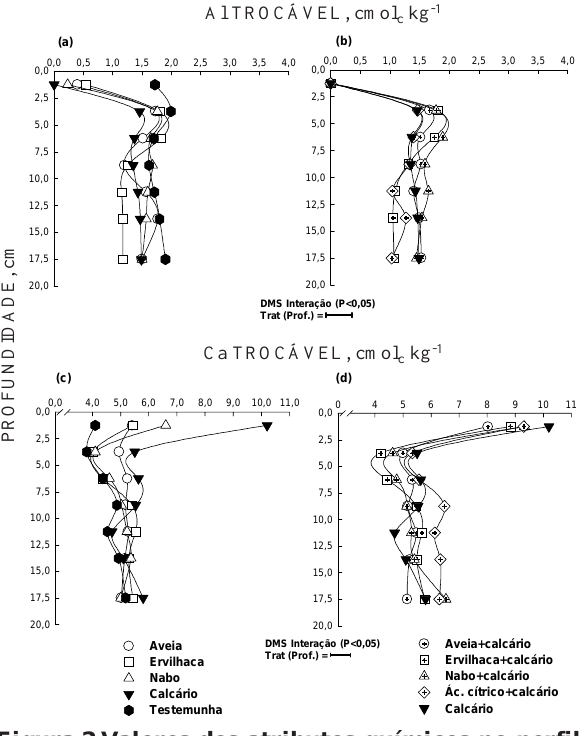
Figura 2 Valores dos atributos químicos no perfil do solo após 60 dias da aplicação superficial dos resíduos, isolados e junto com calcário, em colunas indeformadas, coletadas em área de plantio direto: calcário no alumínio trocável (a) e (b) e cálcio trocável (c) e (d).